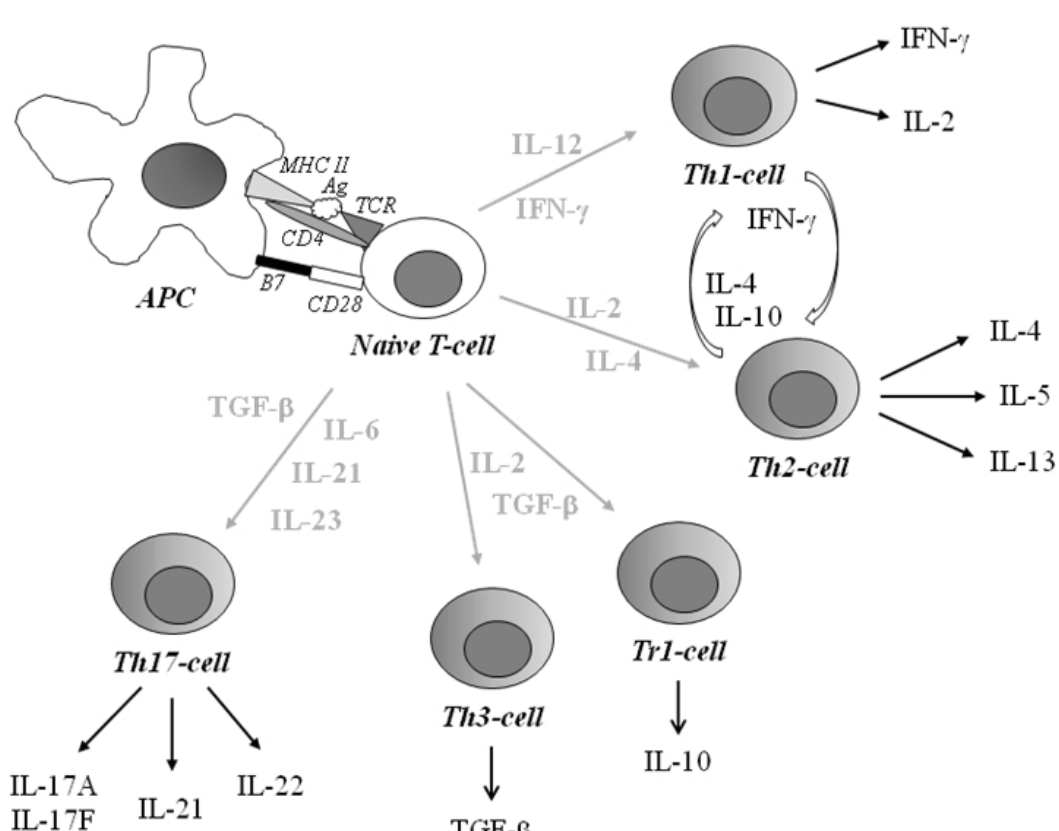
Figure 1. Schematic overview of T-helper subsets. The antigen presenting cell (APC) presents a degraded antigen (Ag) bound to the MHC class II. The complex is recognized by the T-cell receptor (TCR) and delivers a first signal for T-cell activation and a secondary signal by interaction between B7 and CD28. Through stimulation, a naïve T-cell can differentiate into different T-helper (Th) cells. Th1-cells, producing IFN- (cid:2) and IL-2, are associated with autoimmunity and intracellular pathogens whereas Th2-cells are associated with allergy and asthma and extracellular parasites and produce IL-4, -5 and -13 upon activation. Inducible antigen-specific sub-populations of CD4 + T-regulatory (Treg) cells are IL-10-producing T-regulatory cell type 1 (Tr1) cells and transforming growth factor (TGF)-(cid:3)-secreting Th3 cells. Th17-cells producing IL-17A, -17F, -21 and IL-22 are capable of inducing inflammation and